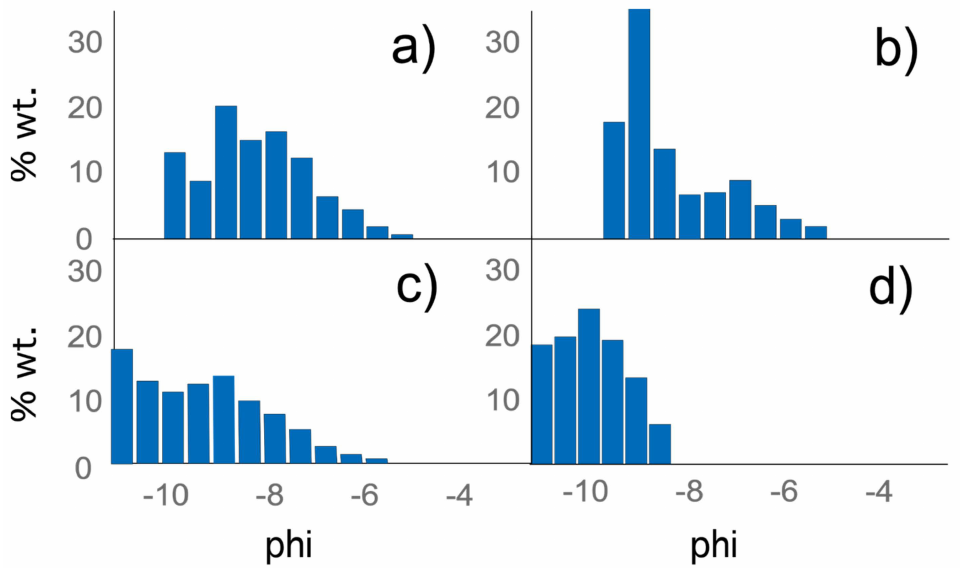
Figure 9. Size distribution of particles emitted in ( a ) explosion 1e, ( b ) explosion 2e, ( c ) explosion 3e, ( d ) explosion 4e of Table